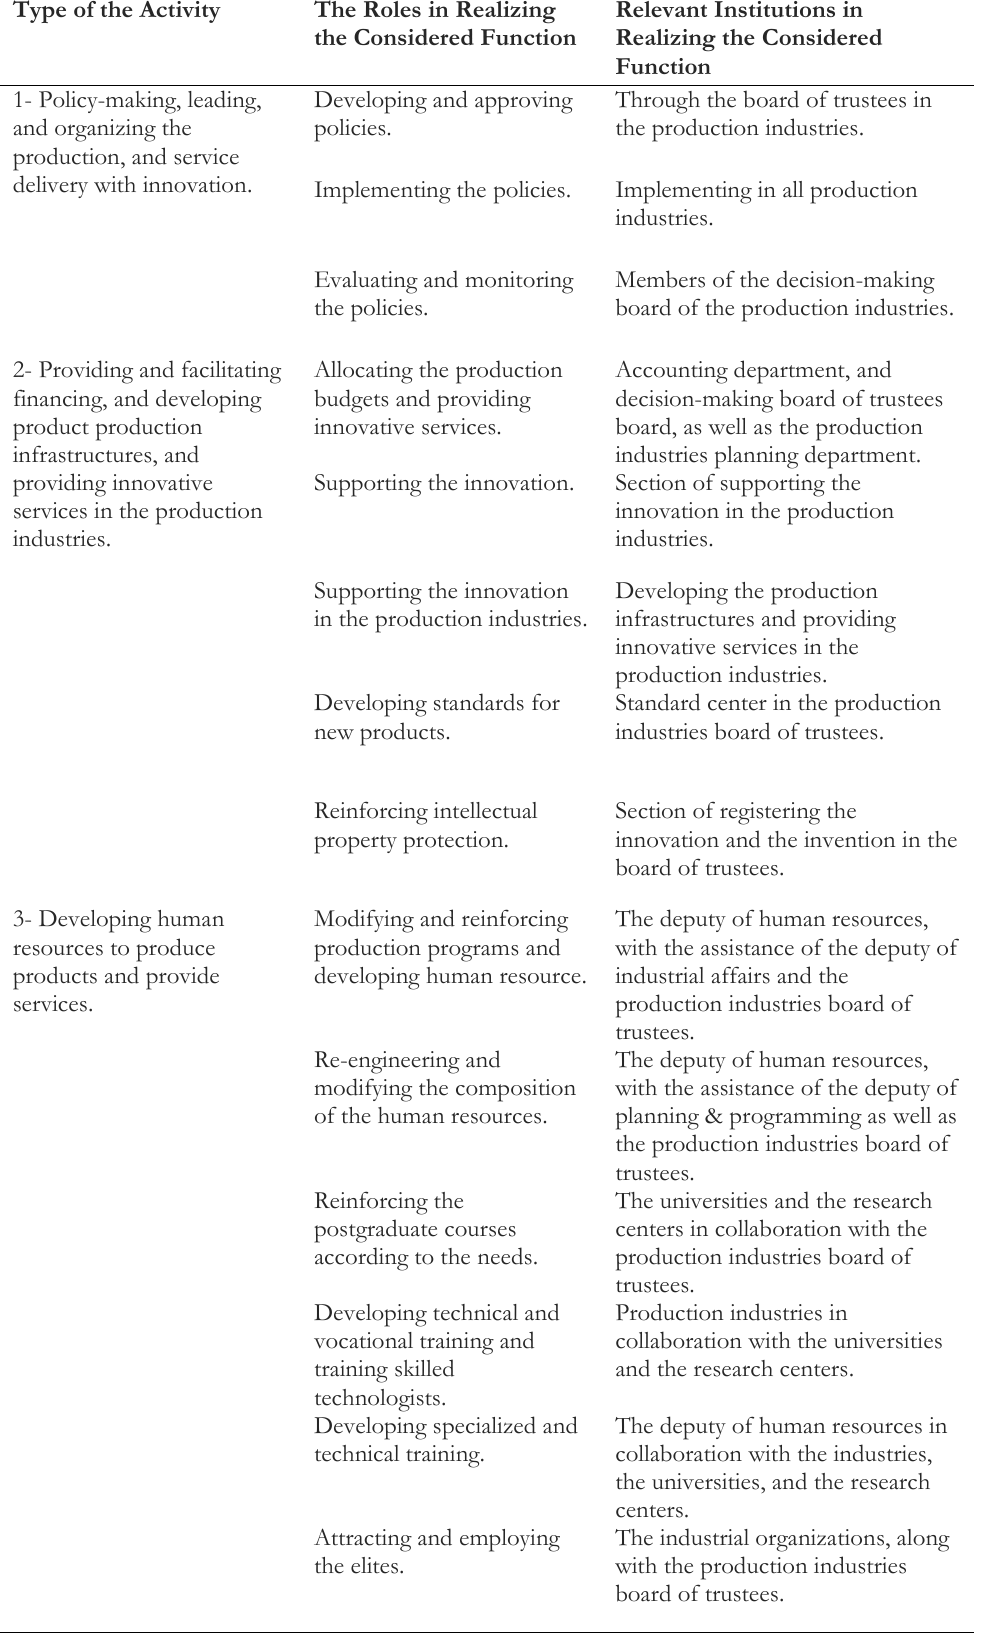
Table 1. The role of institutions in the field of the production and service functions in the innovation